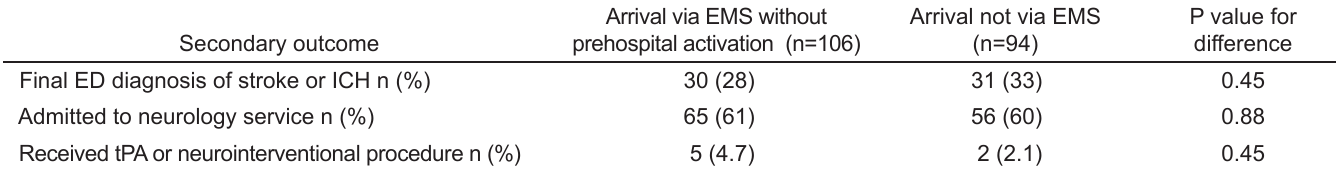
Table 2. Secondary clinical outcomes by mode of